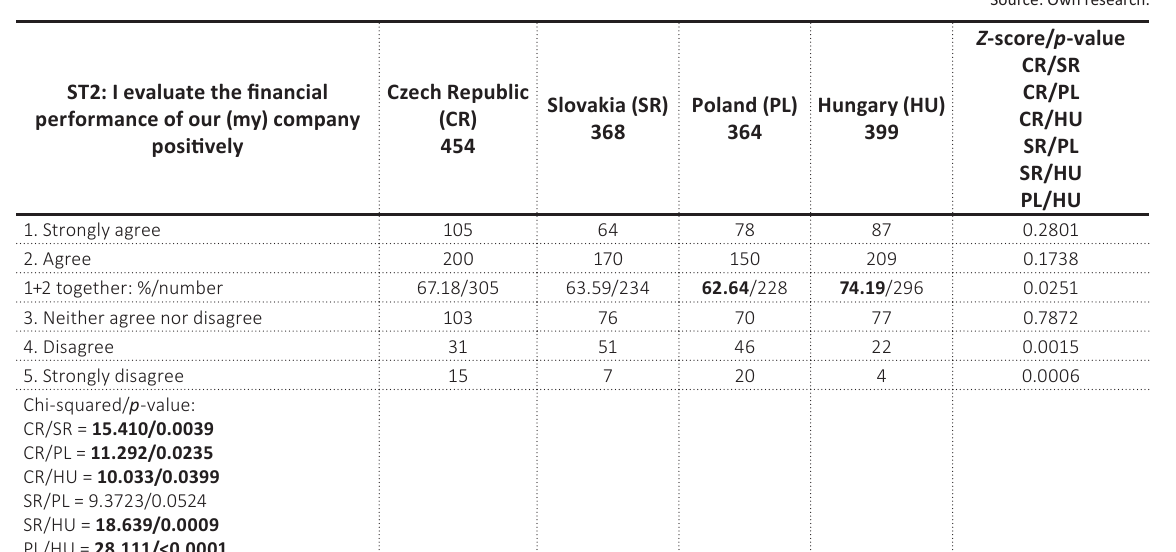
Table 2. Evaluation of own company’s financial performance in the V4 countries